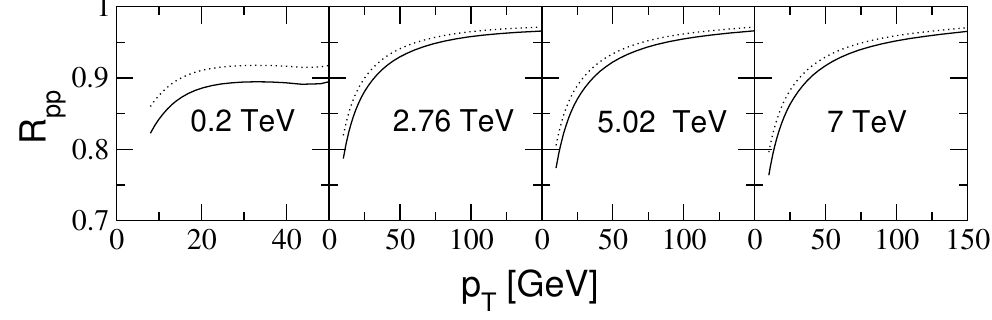
Figure 3 . R pp of charged hadrons for 0 . 2 , 2 . 76 , 5 . 02 and 7 TeV pp collisions from our calculations for τ 0 = 0 . 5 (solid) and 0 . 8 fm (dotted) with κ = 2 . 55 obtained by fitting all the LHC data on R AA for heavy ion collisions with the geometrical parameter k = 2